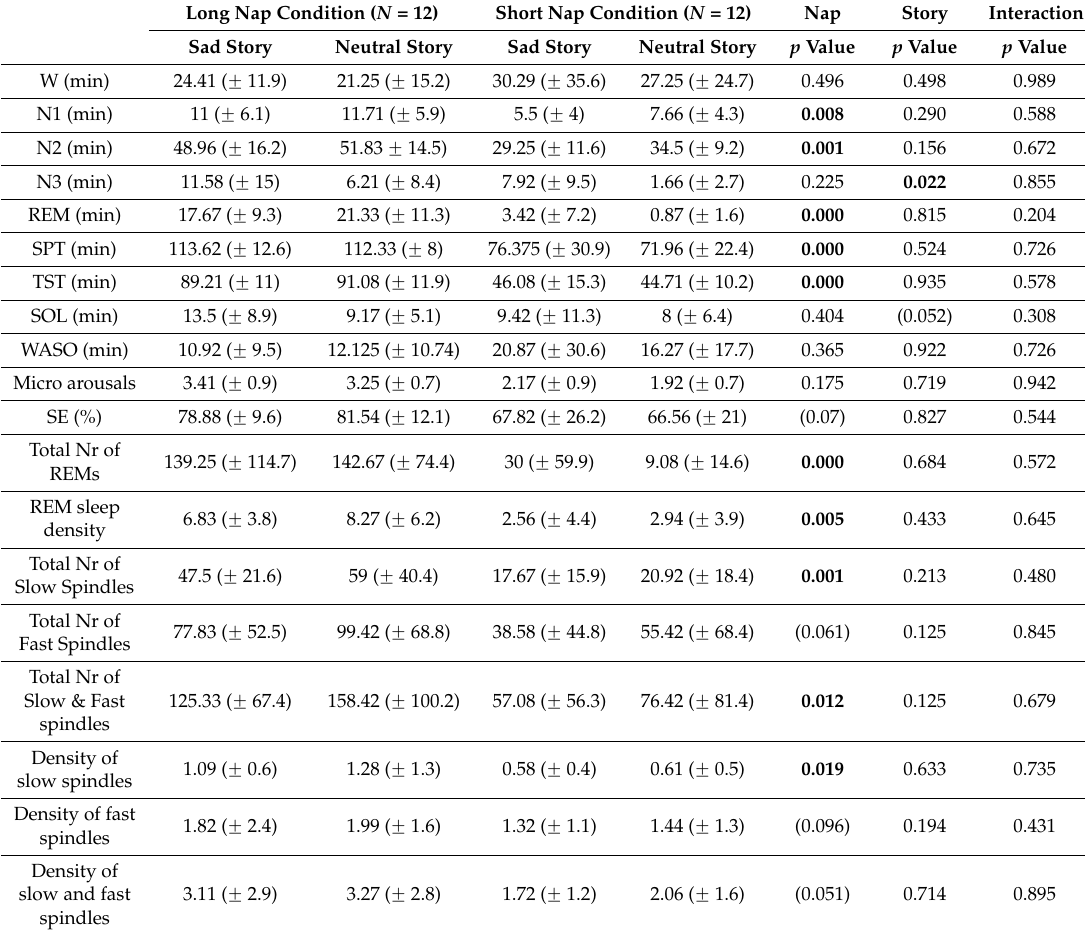
Table 2. Diurnal sleep (naps) macro-and micro-structural measures (mean (SD). Long Nap Condition ( N = 12) Short Nap Condition ( N = 12) Nap Story Interaction Sad Story Neutral Story Sad Story Neutral